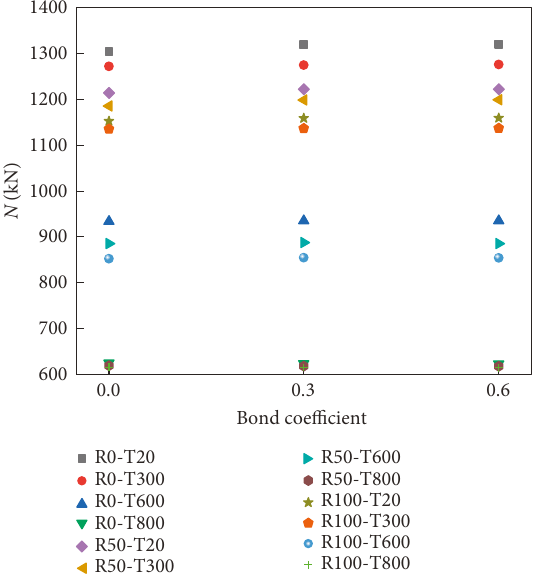
Figure 10: Influence of bond strength coefficient on ultimate bearing